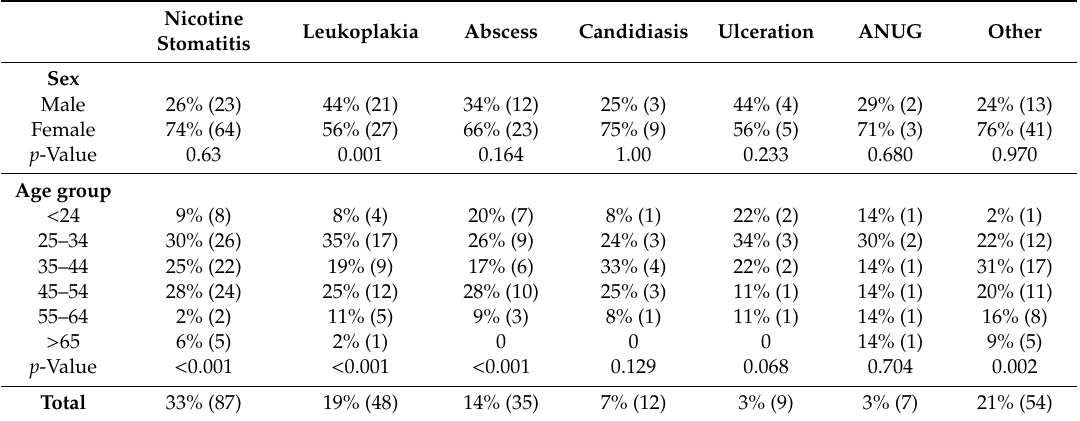
Table 2. Distribution (% and count) of different oral mucosal lesions according to sex and age group.